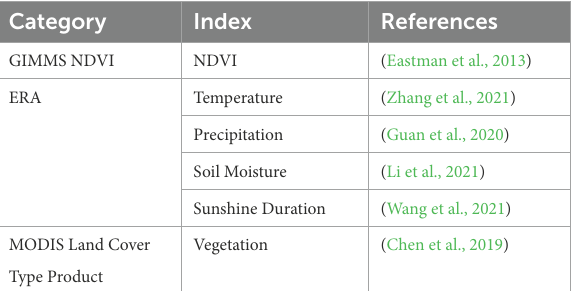
TABLE 1 Remote sensing vegetation data and climate factor data from 1981 to